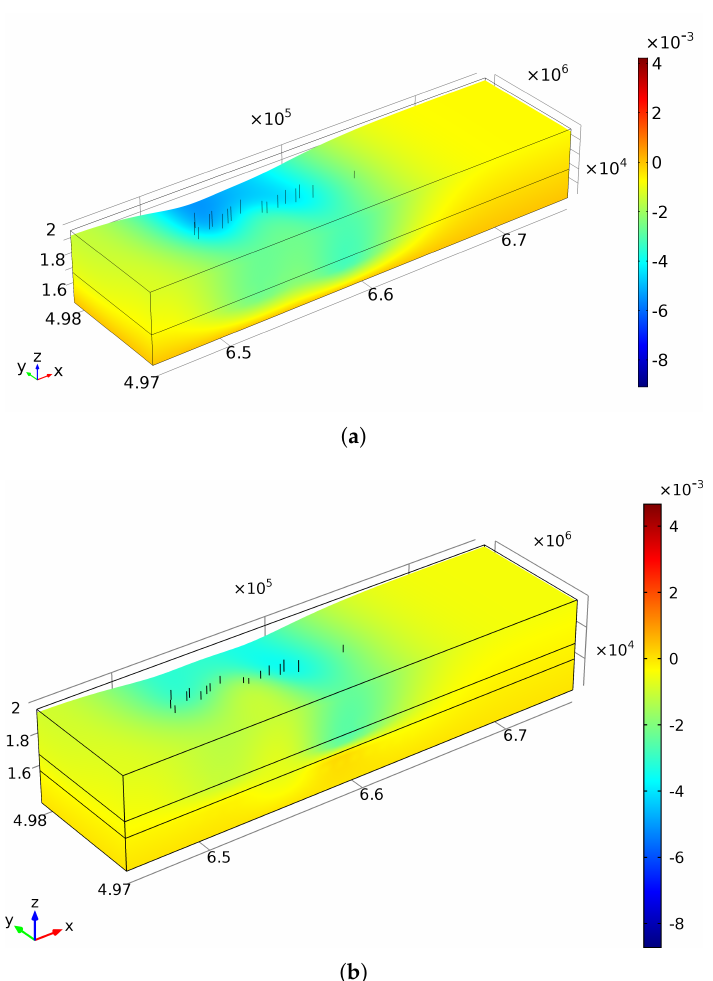
Figure 7. Cavone oilfield modeling—Vertical displacement or subsidence of the reservoir model at the end of the simulation for the two-layer ( a ) and the three-layer ( b ) models; dimensions are in